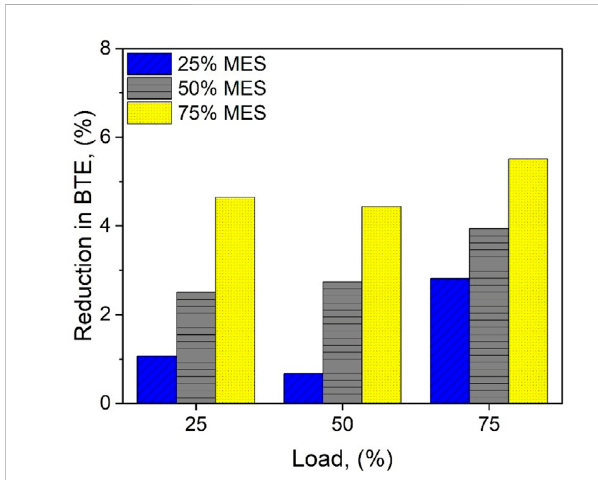
FIGURE 6 PercentagechangeinNOemissionswithrespecttodieselfuelwith varying MES level at different loads.